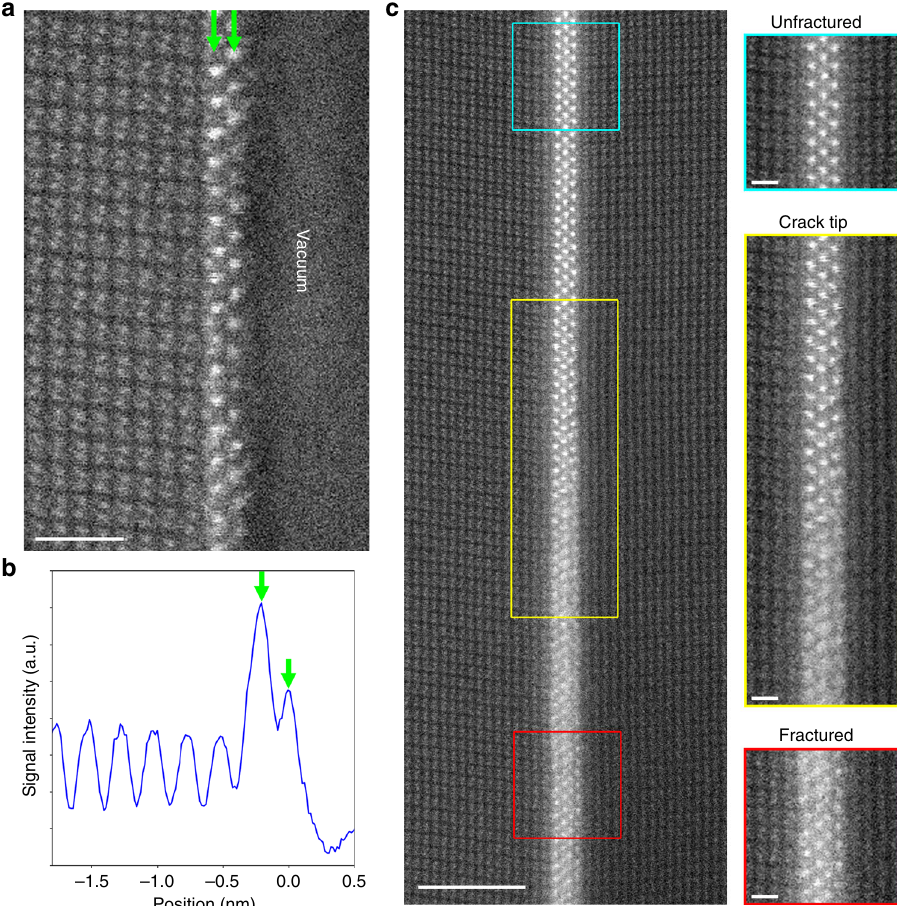
Fig. 2 HAADF-STEM images of the fracture surface and the crack tip. a HAADF-STEM image of the fracture surface. The two Zr layers indicated by the green arrows remain on the fracture surface. The scale bar is 1 nm. b Intensity pro fi le of the HAADF-STEM image along the horizontal direction. The signal is averaged along the vertical direction. The green arrows indicate the position of the outermost layer and the inner layer. The intensity of the outermost Zr layer becomes lower than the inner layer. c HAADF-STEM image of the introduced crack tip. The scale bar is 3 nm. Enlarged views of the upper (blue), middle (yellow), and lower (red) parts are also shown in the right side. The scale bars in the enlarged images are 0.5